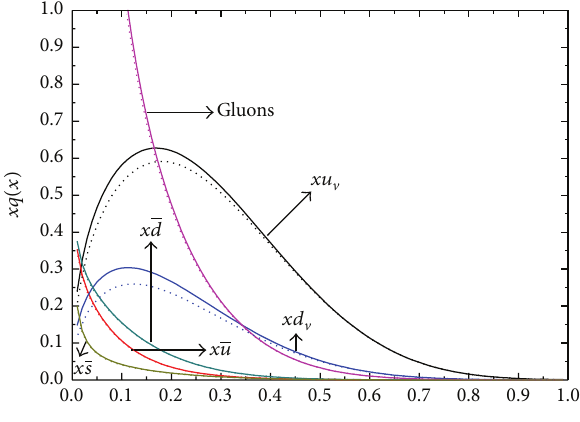
Figure 7: Distribution function of valance and sea quarks inside 63 Cu nucleus at 𝑄 2 = 20 GeV 2 . The full curve is obtained by considering the pionic contribution and the dashed line is plotted without considering the pionic